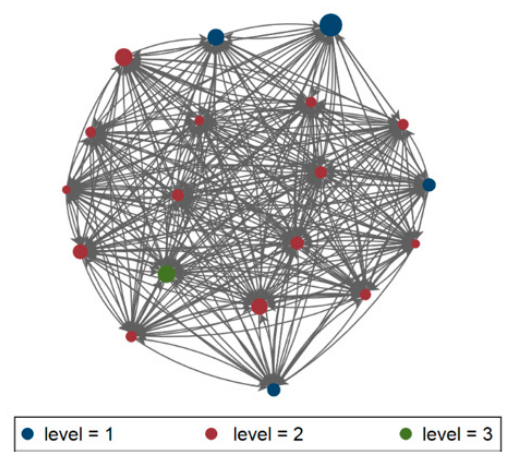
Figure 4. Visualization of the Marches HDR Network, 2013–2014. Node colour corresponds to facility type (I, II, III level of care), and size of node corresponds to number of admissions.